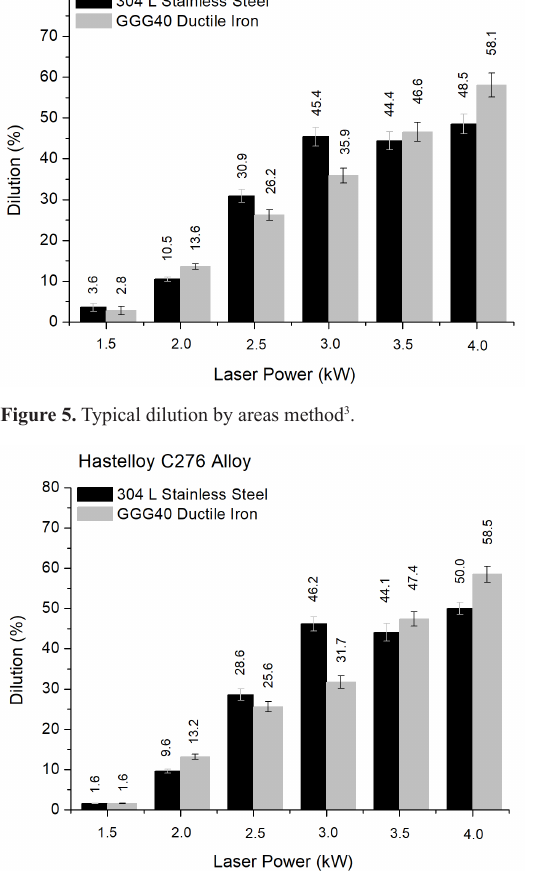
Figure 6. Typical dilution by Toyserkani method 8 .